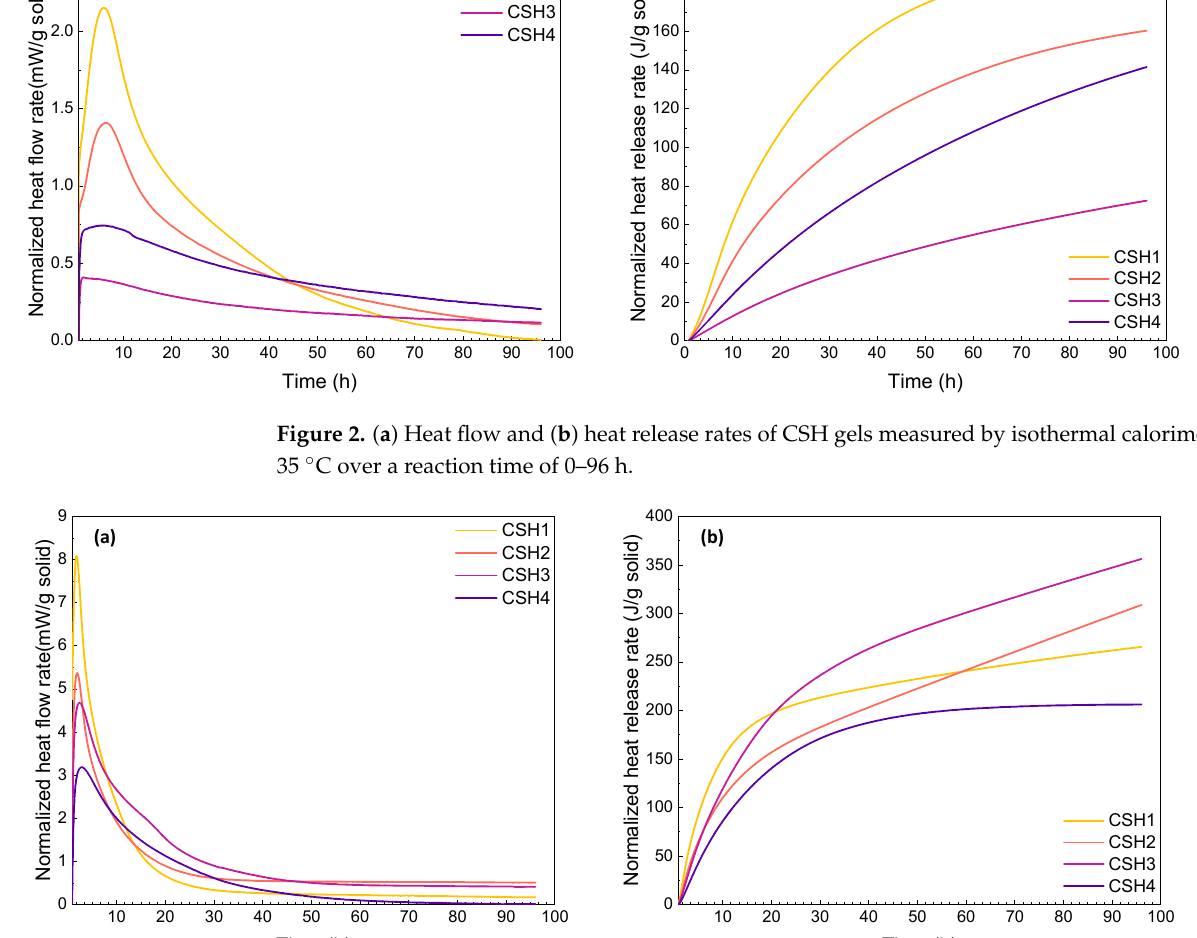
Figure 2. ( a ) Heat flow and ( b ) heat release rates of CSH gels measured by isothermal calorimetry at 35 °C over a reaction time of 0–96 h. Figure 3. ( a ) Heat flow and ( b ) heat release rates of CSH gels measured by isothermal calorimetry at 50 °C over a reaction time of 0–96 h.